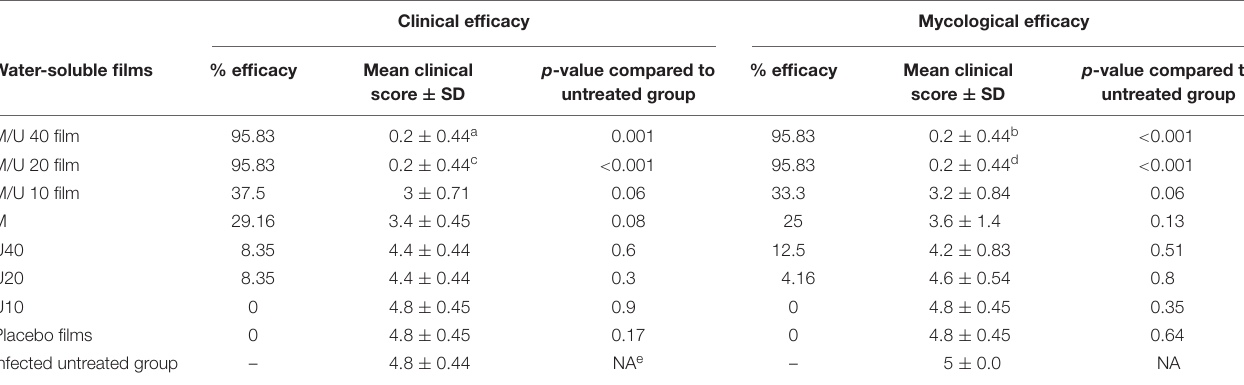
TABLE 5 | Summary of mycological and clinical efficacies of different medicated water-soluble films. Clinical